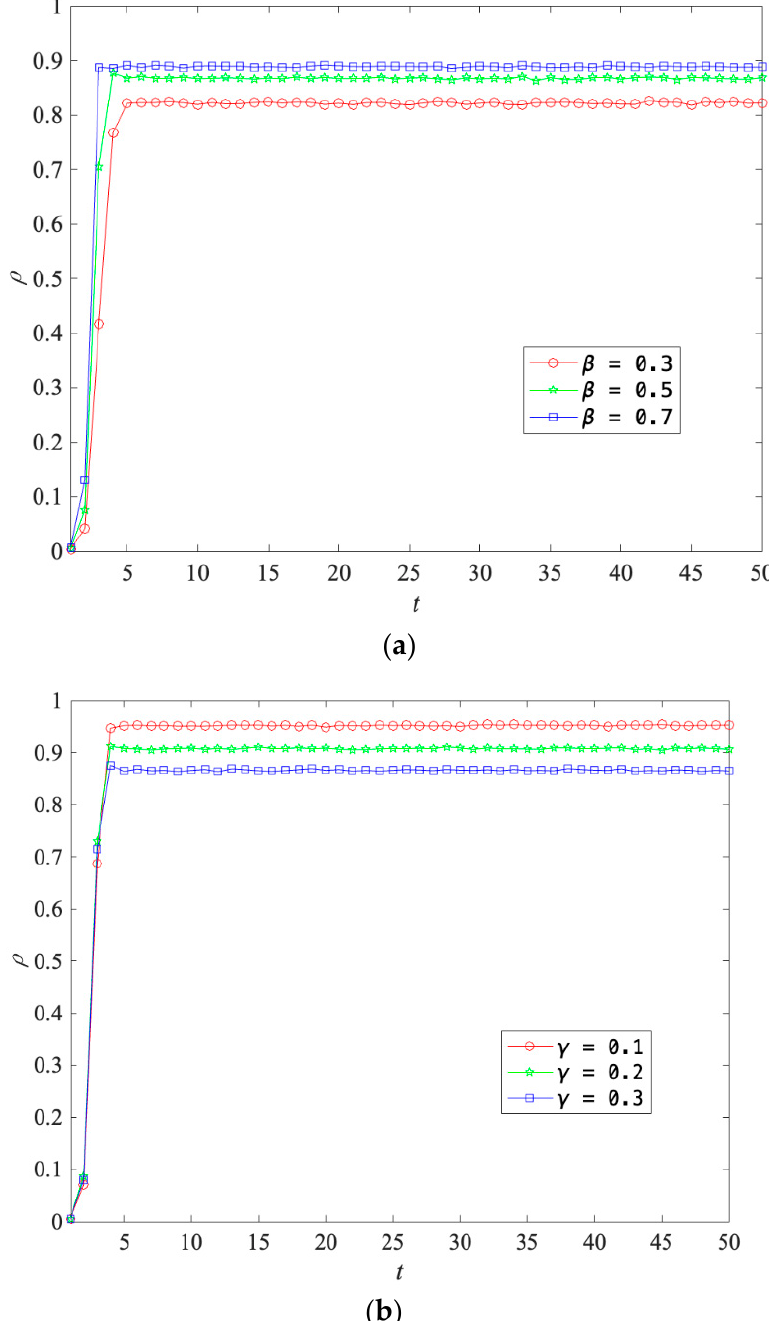
Figure 10. The simulated density of infected nodes ρ vs. time t for different spreading rates of β ( a ) and recovering rates of γ ( b ).